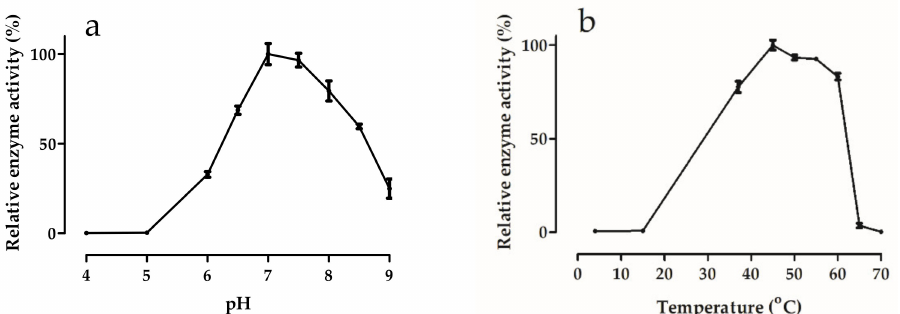
Figure 3. Effects of ( a ) pH and ( b ) temperature on Hmc Isc activity. Error bars represent standard error values for three replicates. Activities are expressed as a percentage of the maximal activity. An optimal T of 45 ◦ C was chosen for the pH optimization. An optimal pH of 7.0 was selected for the T optimum determination. Sucrose and salt (NaCl) concentrations were 150 mM and 3.5 M, respectively, and reaction time was 24